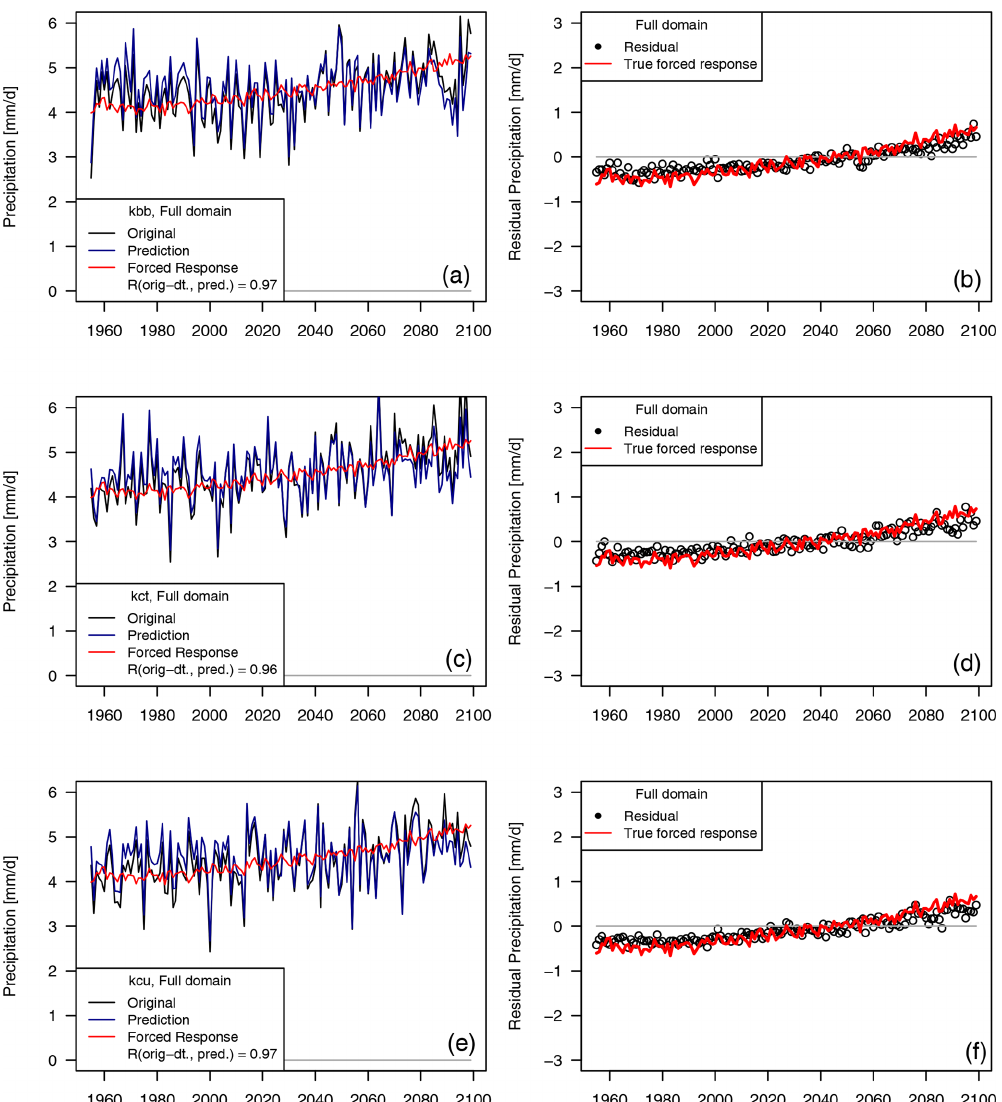
Figure B4. Dynamical adjustment of the full domain (land grid cells only) but training only based on 1955–2020 and with precipitation detrended instead of SLP before model training and dynamical adjustment. (a, c, e) Seasonal precipitation totals simulated by three members of the high-resolution RCM in black ( a : “kbb”, c : “kct”, e : “kcu”), the predicted (“circulation-induced”) component for three “holdout” ensemble members (blue) and the forced response (average across all 50 members, red). (b, d, f) Residuals from the prediction (black dots) and the forced response